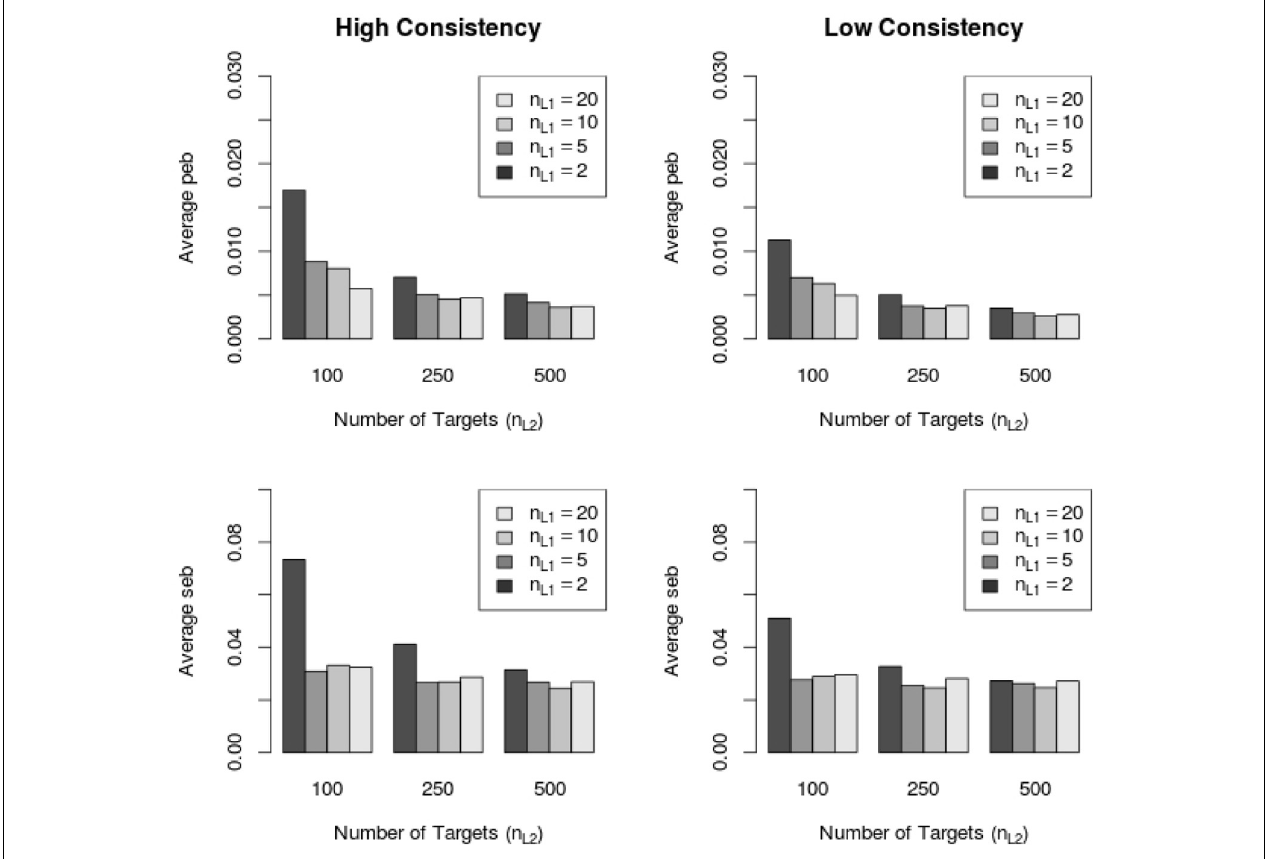
FIGURE 6 | Average peb and seb values with respect to sample size in high and low consistency conditions in the LS-COM model. n L 1 = number of Level 1 units; n L 2 = number of Level 2